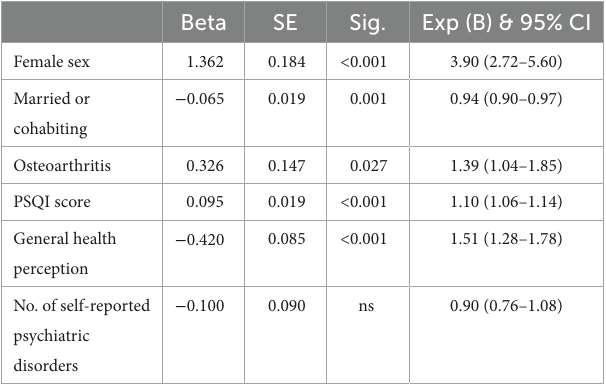
TABLE 6 Logistic regression to identify predictors of self-reported chronic fatigue